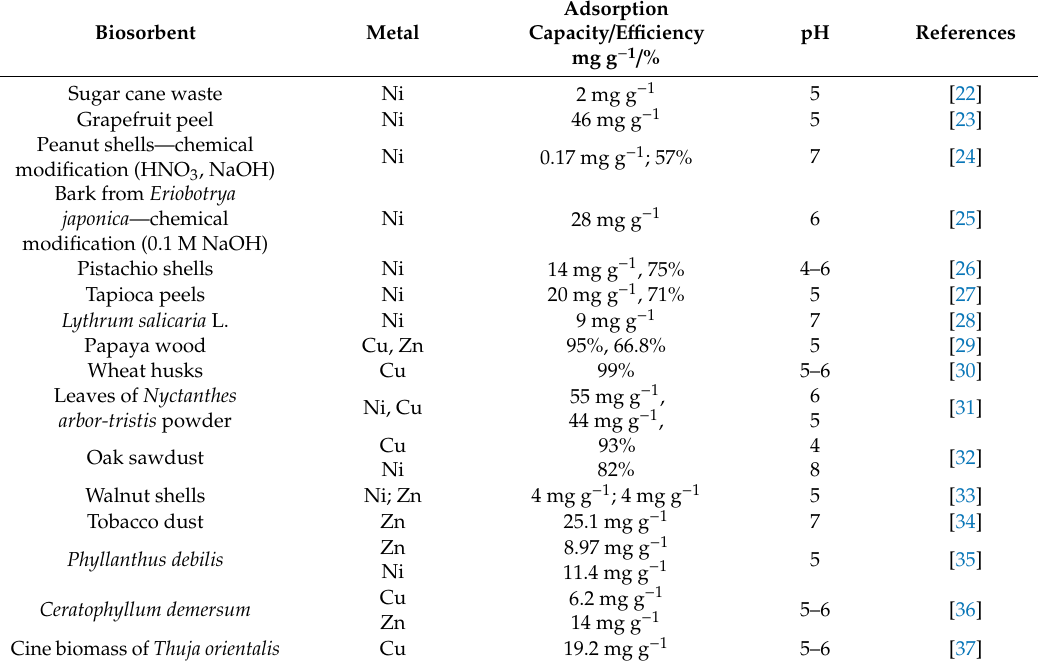
Table 1. Selected pilot studies focused on the removal of the metals of interest from aqueous solutions using the biosorption